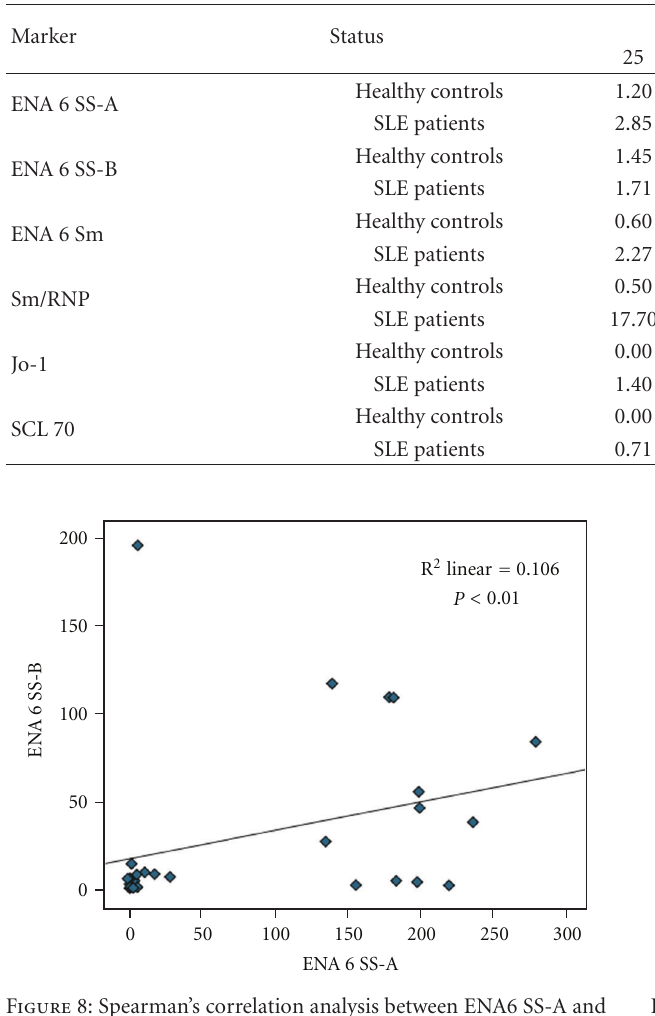
Figure 8: Spearman’s correlation analysis between ENA6 SS-A and ENA6 SS-B.